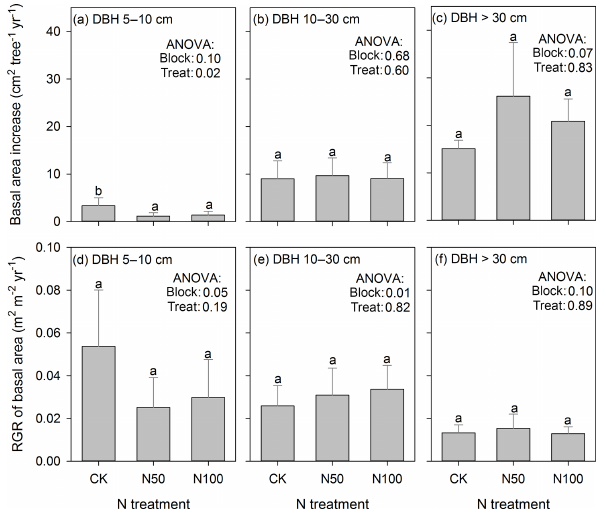
Figure 3. Effects of N fertilization on the growth (mean ± SE) of C. eyrei by DBH classes (5–10, 10–30 and > 30cm). (a–c) Abso- lute basal area increase and (d–f) relative growth increase rate of basal area. Numbers in these figures indicate the results of ANOVA. The N treatment on the x axis represents three levels of N fertiliza- tion: CK (0kg Nha − 1 yr − 1 ) , N50 (50kg Nha − 1 yr − 1 ) , and N100 (100kg Nha − 1 yr − 1 ) .